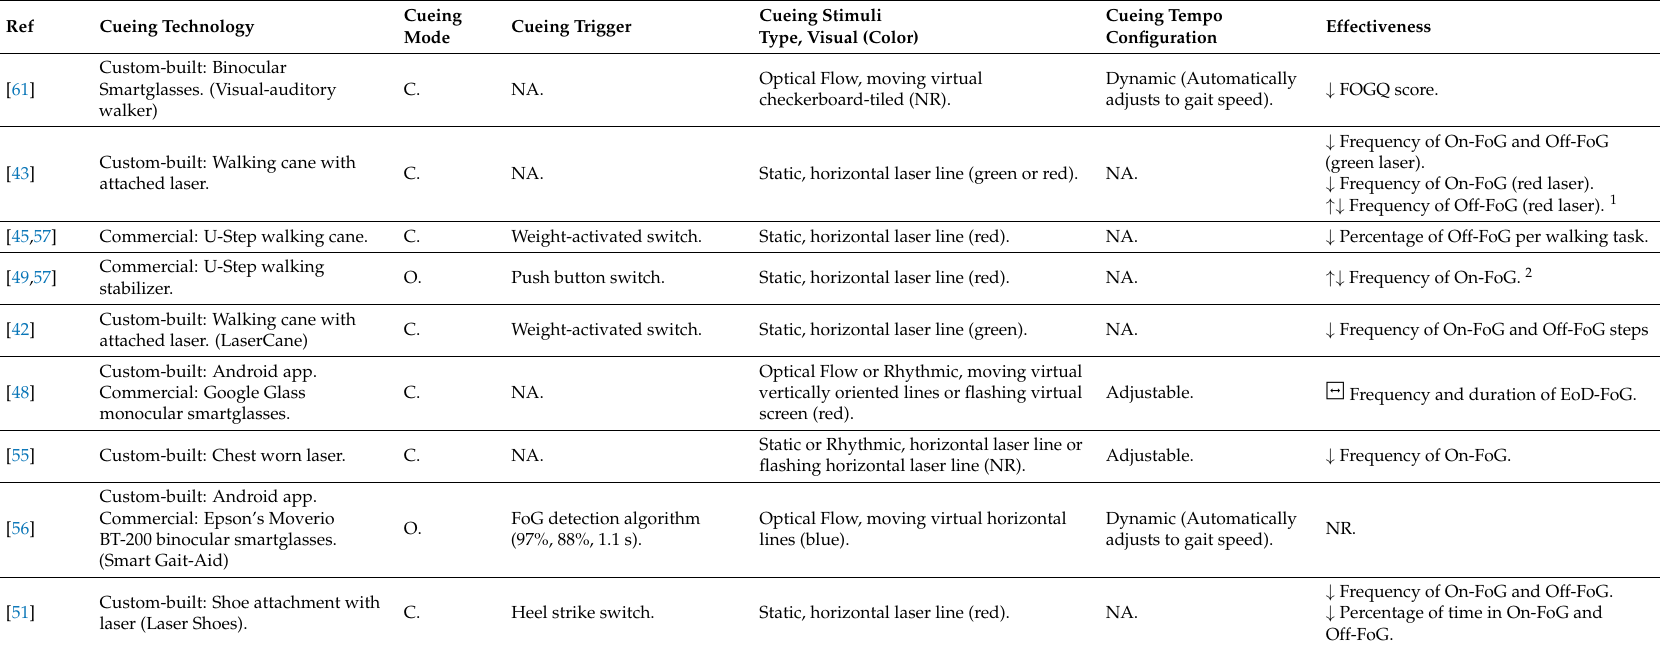
Table 3. Overview of visual cueing devices.